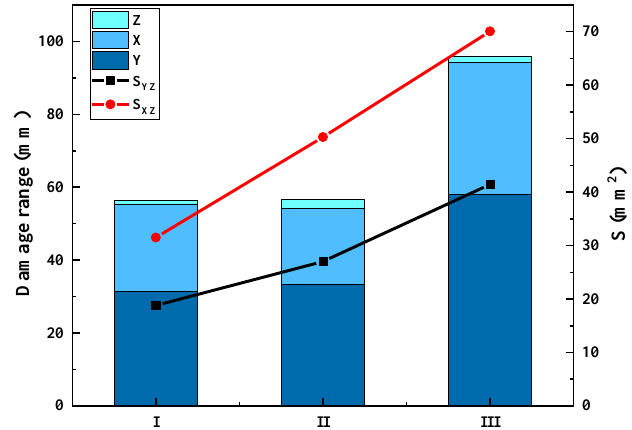
Figure 13. Statistical results for damage range span and damage areas.